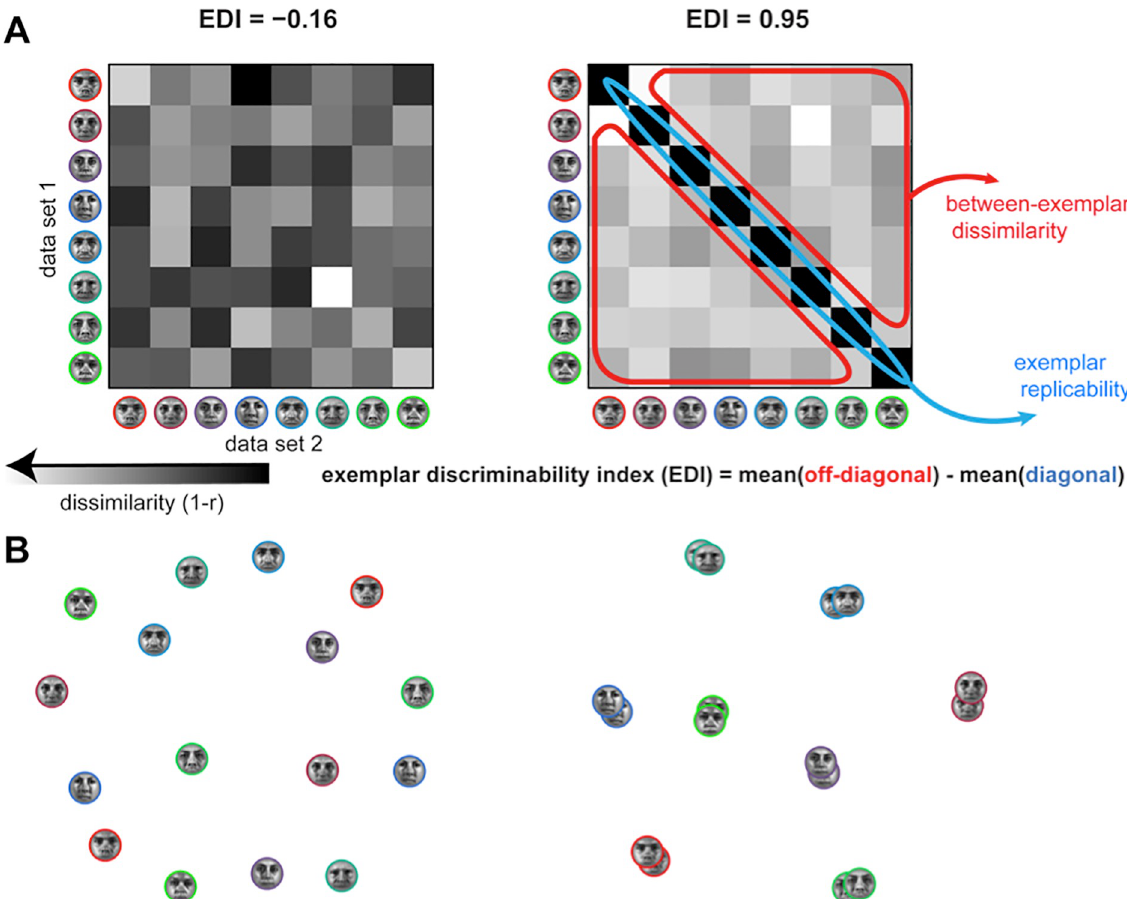
Fig 1. Definition of the exemplar discriminability index (EDI). (A) The exemplar discriminability index (EDI) is defined as the difference of the average between-exemplar and average within-exemplar distance. Split-data RDMs (sdRDMs) are shown for two scenarios. In the scenario on the left, the face exemplars are not discriminable and the EDI is insignificant (H 0 simulation). In the scenario on the right, the EDI is large and exemplars are discriminable (H1 simulation). (B) Applying multi-dimensional scaling (MDS; Kruskal and Wish, 1978; Torgerson, 1958) allows simultaneous visualisation of the representational geometries from both data sets (H 0 on the left, H1 on the right). Exemplars are colour- coded and there are two pattern estimates for each exemplar. MDS gives a low dimensional (2D here) arrangement, wherein the distances between projections approximate the original distances in the high-dimensional pattern space. Here, to obtain MDS plots, we consider a distance matrix composed of comparisons between any two patterns (aggregated from both datasets A and B). When the EDI is significantly positive (right), repetitions of the same exemplar yield patterns that are more similar to each other than presentations of two different exemplars.